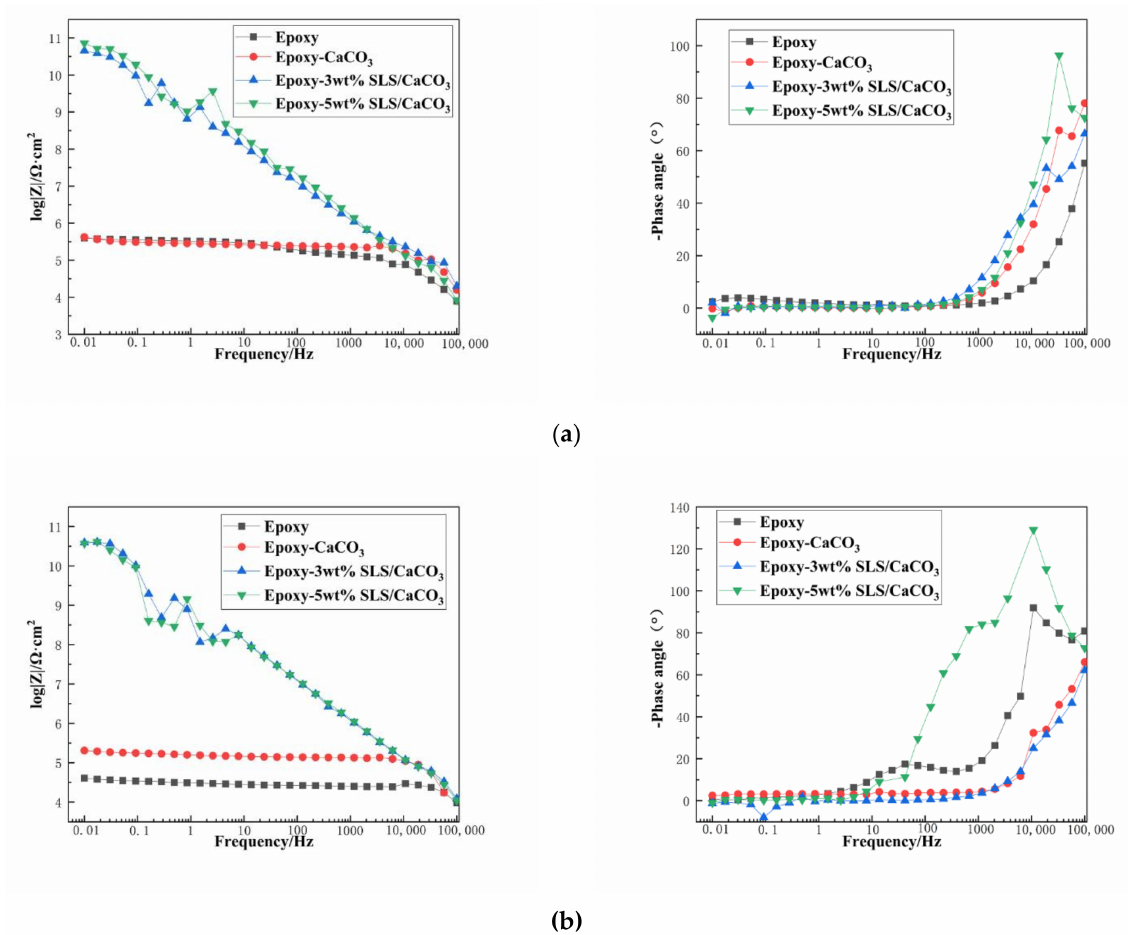
Figure 8. Bode plots for the epoxy coating containing CaCO 3 microparticle with or without SLS as well as the pure epoxy coating, measured after ( a ) 5 days and ( b ) 15 days exposure in the SCP solutions with 3.5 wt% NaCl.